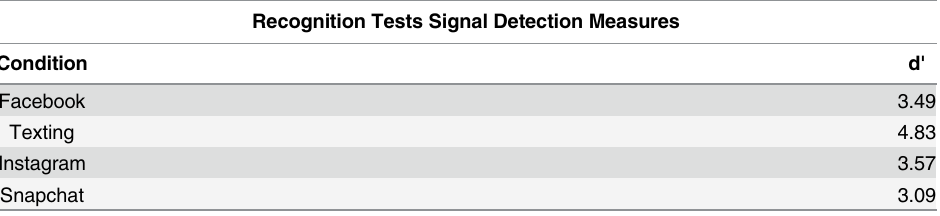
Table 2. Mean d ’ (dprime scores) for each of the 4 recognition task